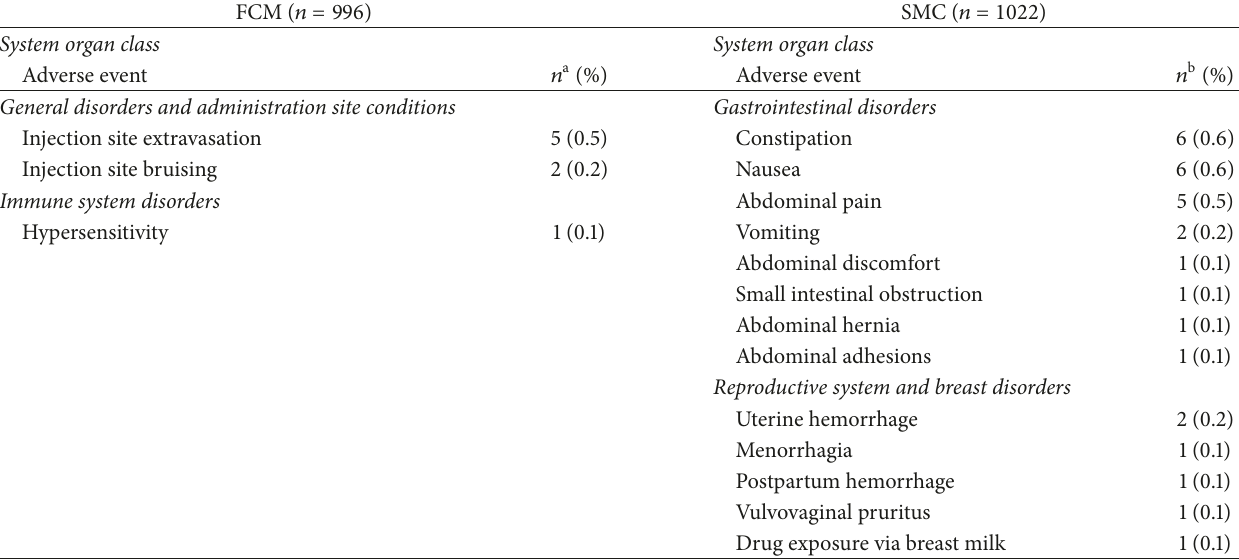
Table 2: Adverse events leading to premature discontinuation of study drug by treatment